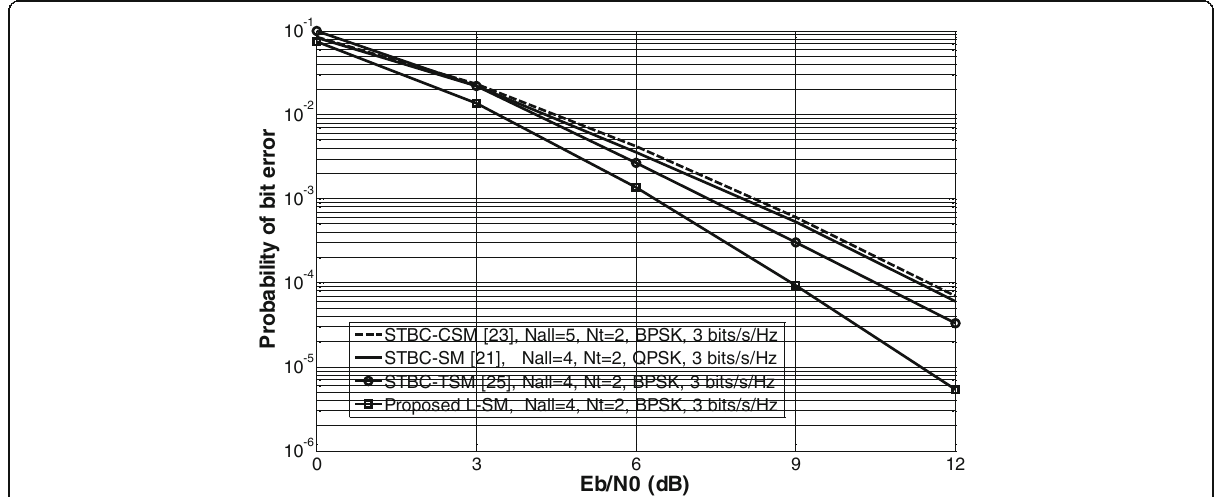
Fig. 5 Performance comparison of STBC-CSM, STBC-SM, STBC-TSM, and proposed L-SM schemes with N r = 2 for 3 bits/s/Hz